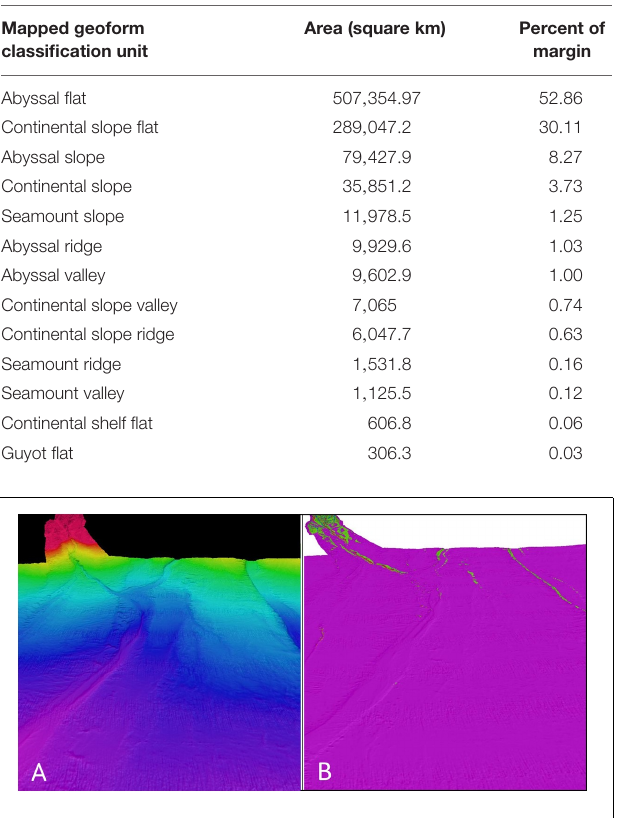
FIGURE 12 | Perspective view comparison of bathymetry data (A) with the classified landform results as draped on bathymetry (B) . Note the presence of channel features in the bathymetry that could not be resolved as geoforms using the landform parameters applied (they were classified as flats as represented by the purple